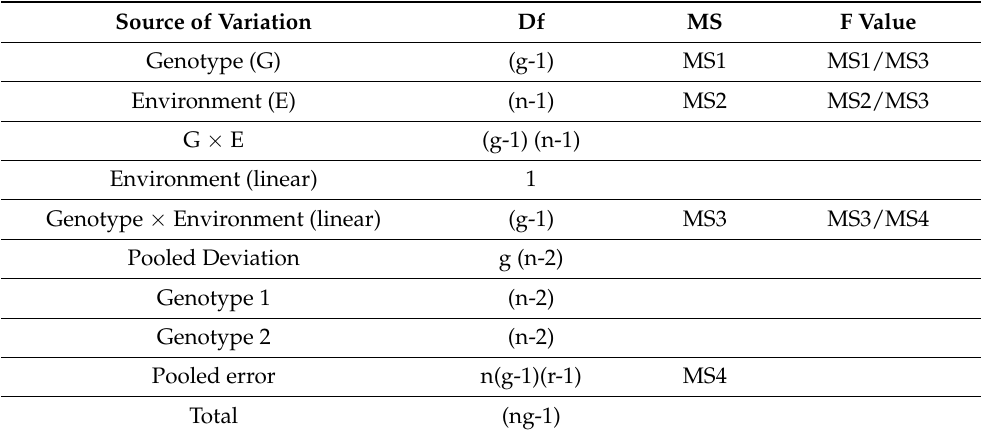
Table 4. Analysis of variance for stability based on Eberhart and Russell